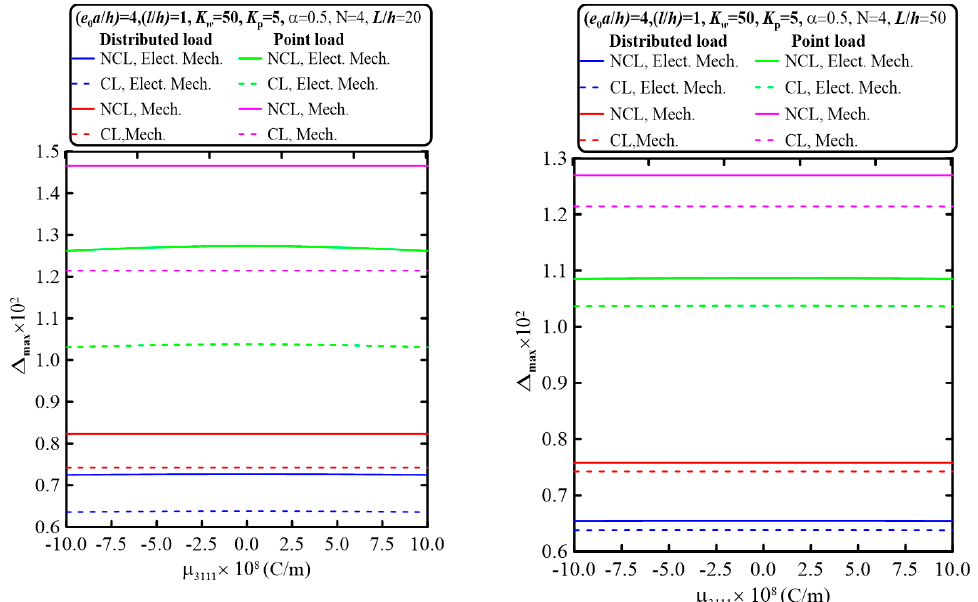
Figure 11. Variation in the maximum normalized transverse deflection ∆ max with the electric-field– strain-gradient coupling coefficient µ 3111 for nonclassical and classical electromechanical and me- chanical behaviors under uniformly distributed and point loads at different values of the nonclassical and elastic foundation parameters at α = 0.5 and beam aspect ratio L / h = 20, 50, h p = 1 nm, h c = 3 nm, h = 15 nm, N = 4, e 311 = − 4.1 C/m 2 , a 33 = 7.124 × 10 − 9 C/m 2 K, and K p = 5 and K w = 50.